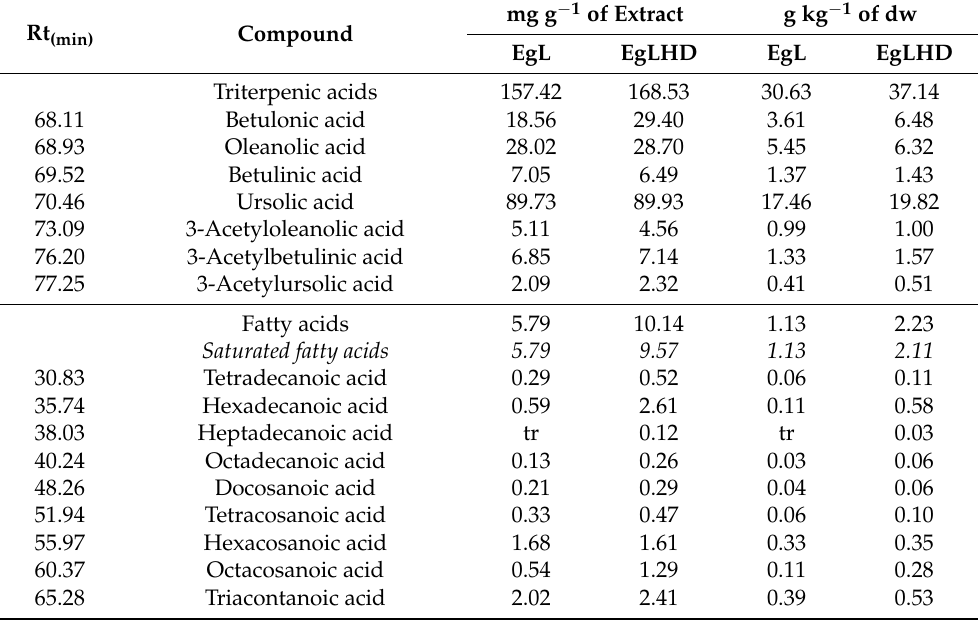
Table 1. Compounds identified in dichloromethane (DCM) extracts of E. globulus leaves before (EgL) and after (EgLHD) hydrodistillation expressed in mg g − 1 of extract and g kg − 1 of dw biomass. Rt